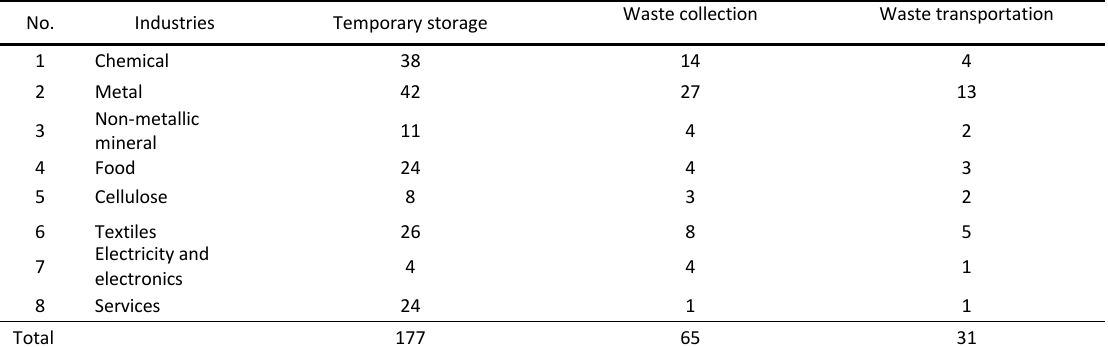
Table 4: The number of industrial units with temporary storage, waste collection and transportation systems in Brujen industrial park